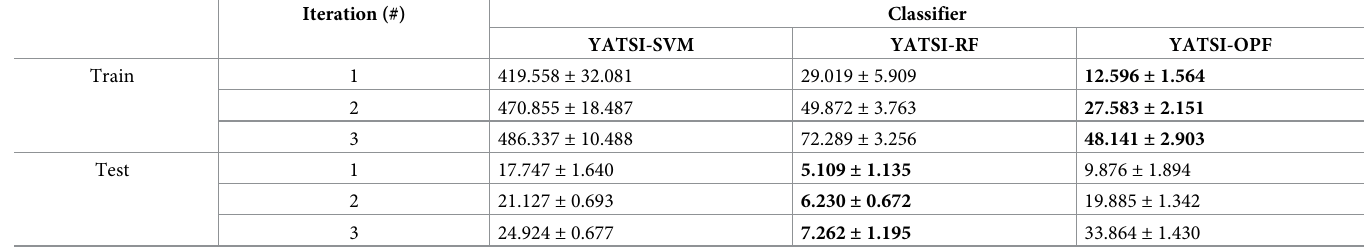
Table 7. Average computational times and standard deviations (in milliseconds) per iteration for the training and testing processes, using the semi-supervised clas- sifiers for the Pl@antLeaves II dataset. The best results (shorter times) are highlighted in